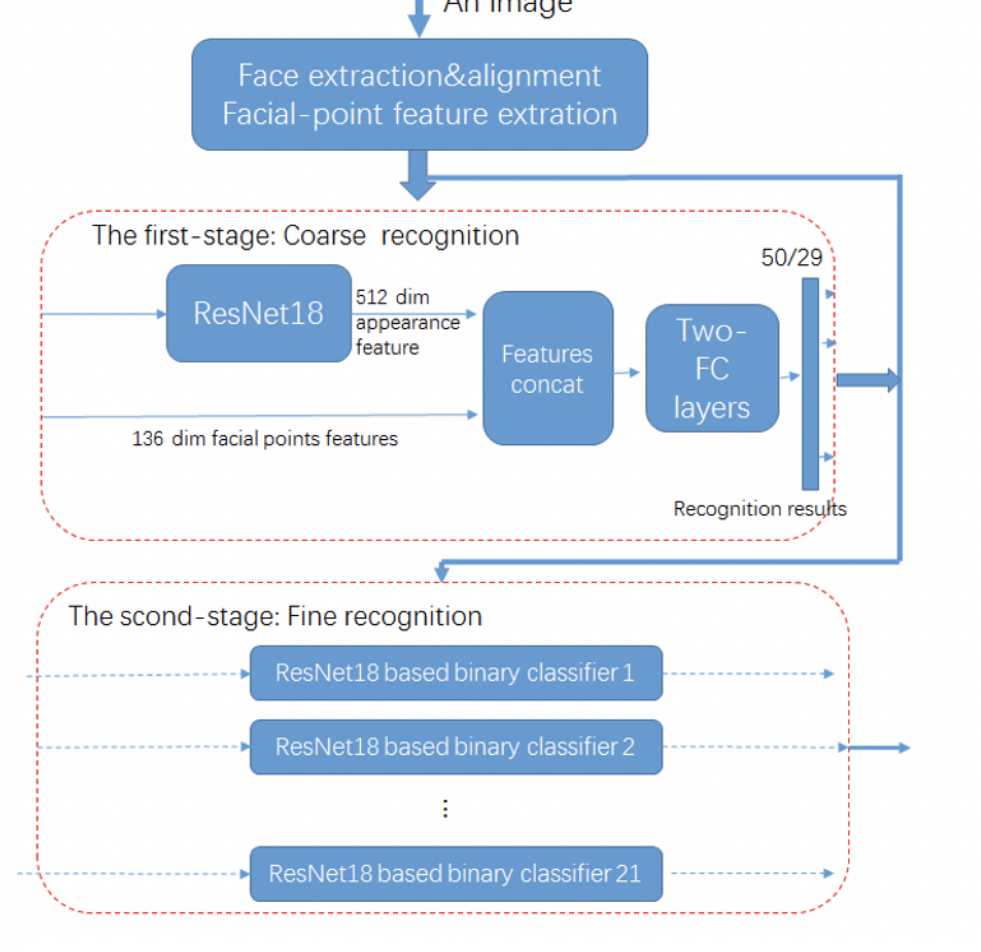
Figure 4. Framework of the proposed